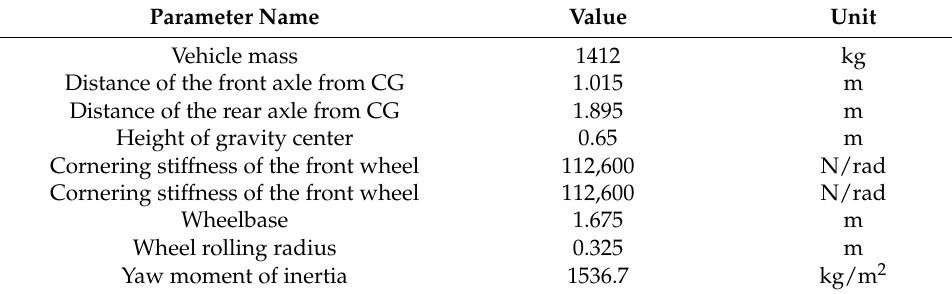
Table 3. Vehicle simulation